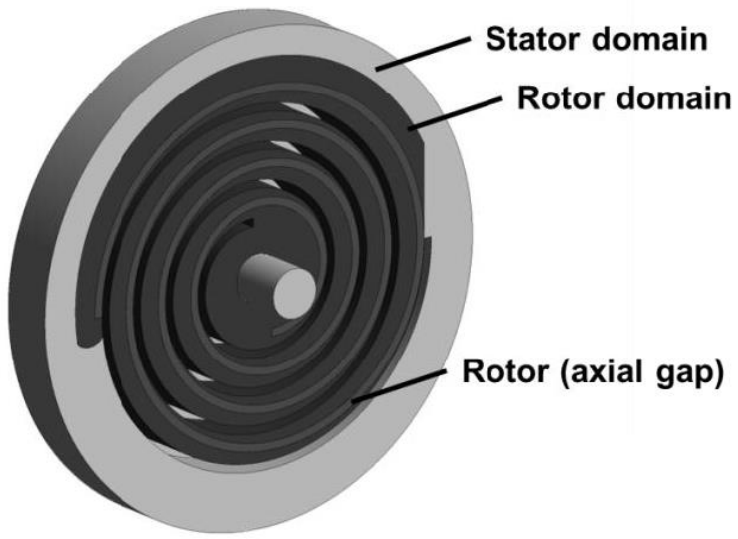
Figure 2. Fluid domains of Twin Mesh [44].